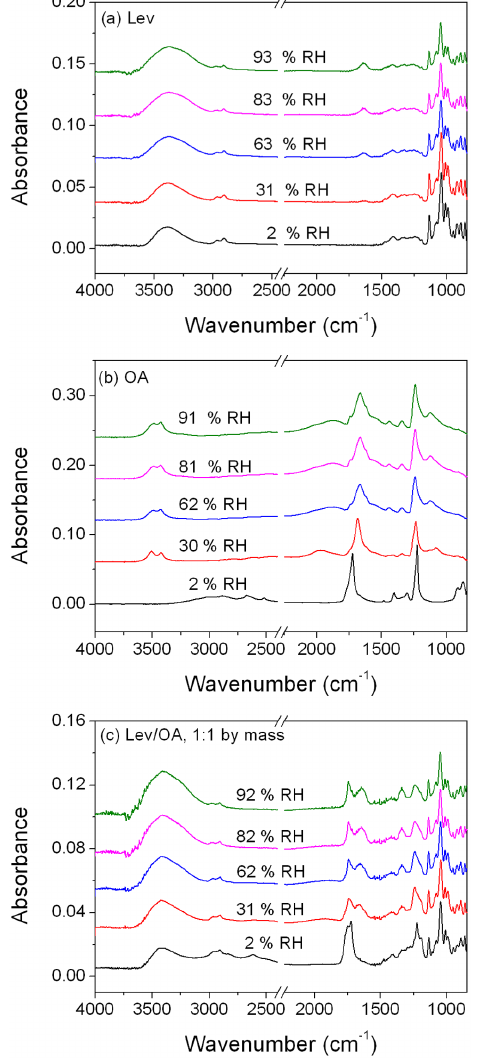
Figure 4. ATR-FTIR absorbance spectra of aerosol particles upon hydration with RH for (a) levoglucosan, (b) oxalic acid, and (c) lev- oglucosan/oxalic acid mixture (1:1, by mass). Features from gas- phase water have been subtracted. Gas-phase CO 2 absorptions have been removed and the spectra have been offset for clarity.